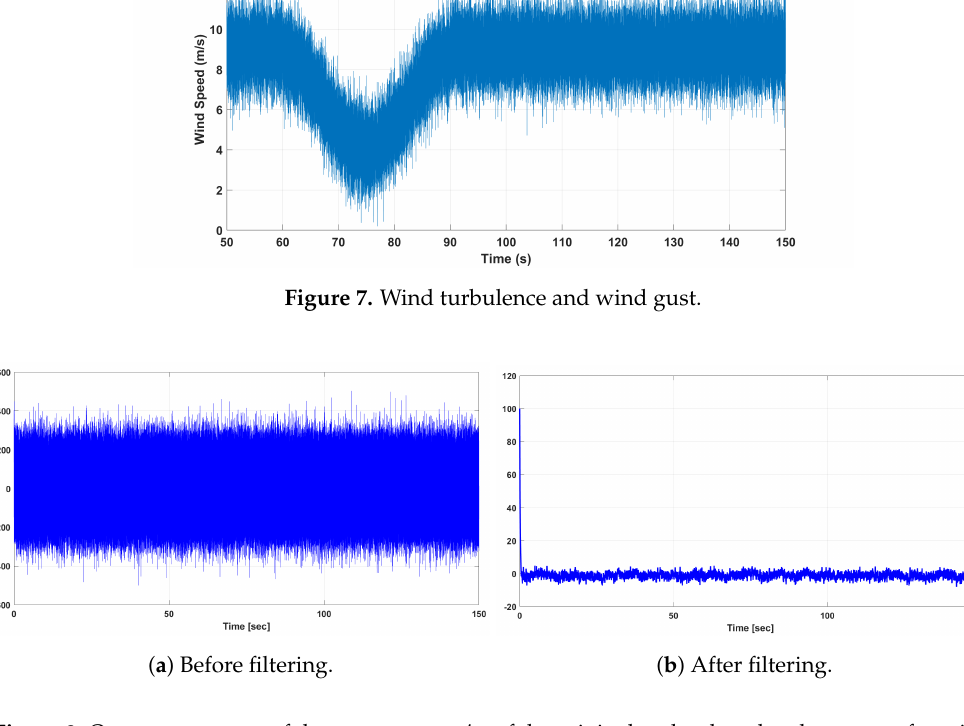
Figure 8. Output responses of the rotor current i dr of the original and reduced-order system for wind turbulence and